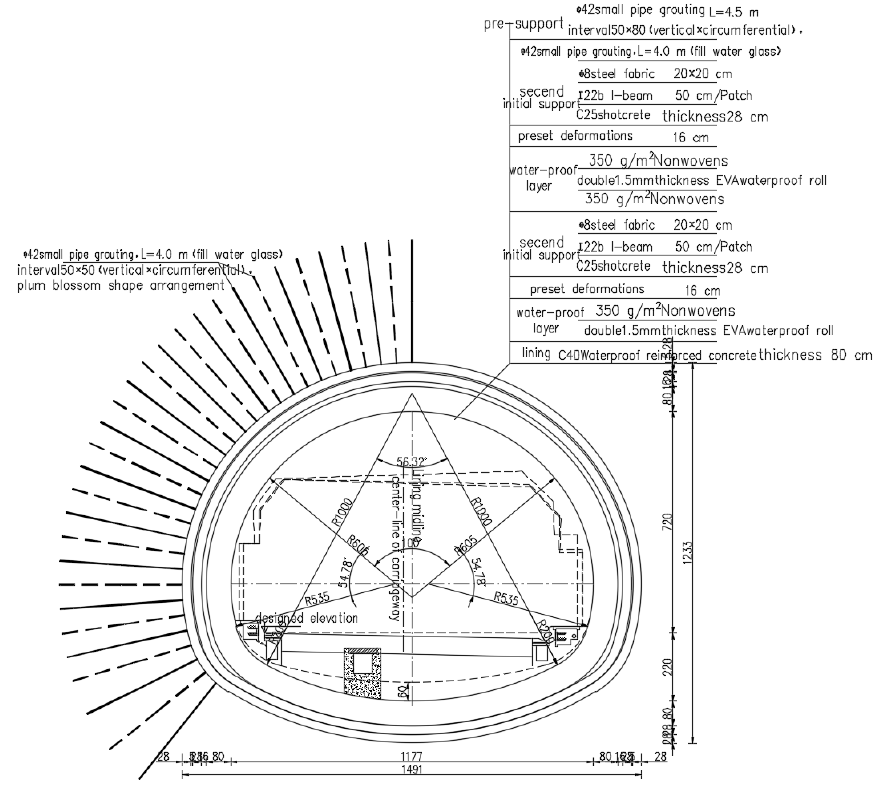
Figure 3. Double-layer initial support structure of high-water-pressure section.